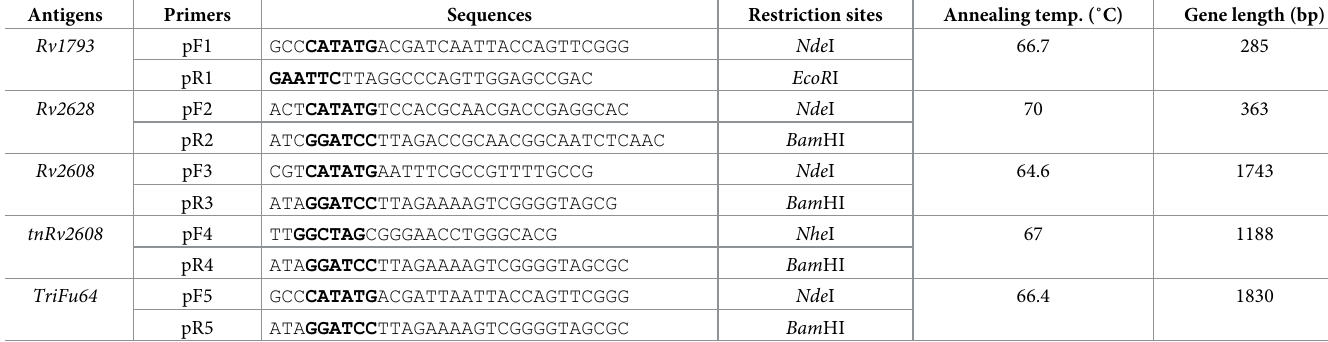
Table 1. List of primers used for PCR amplification of Mtb